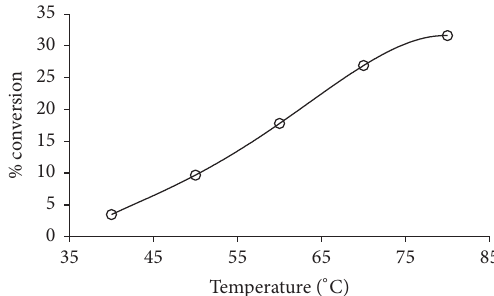
Figure 6: Effect of temperature on conversion of cyclohexanol to cyclohexanone. Reaction conditions : Cat, 0.1g; time, 6hrs; cyclohex- anol, 10mL; flow, 40mL/min; pO 2 , 760 torr; and stirring, 900 rpm.